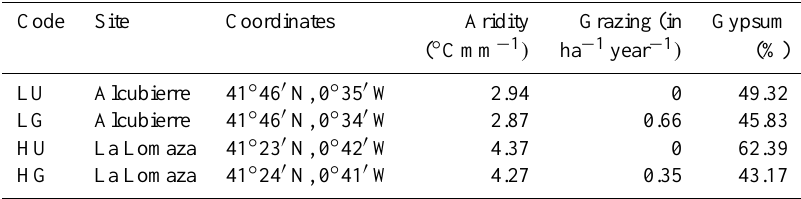
Table 1. Characteristics of the study sites in the middle Ebro Valley,